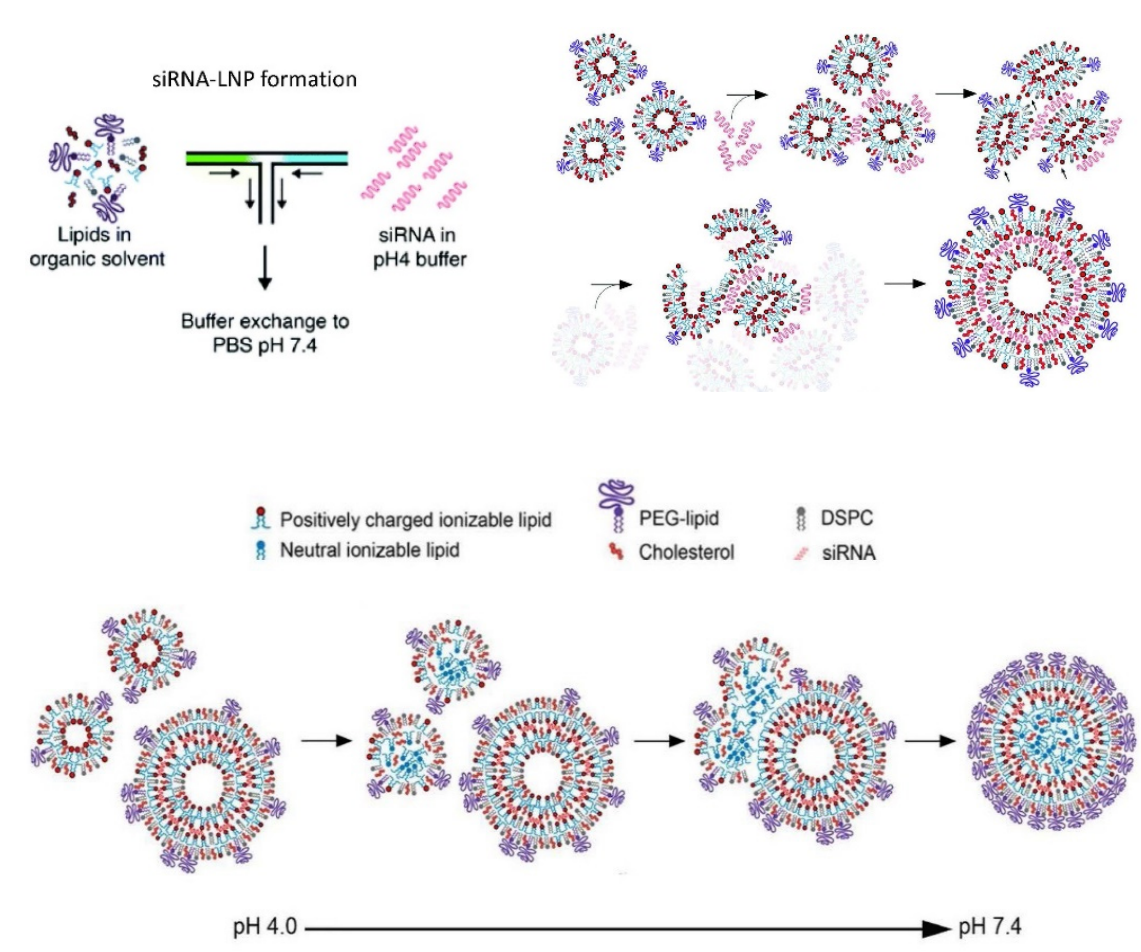
Figure 30. Schematic representation of the formation of siRNA-lipid nanoparticles (LNPs) for the delivery of siRNA to hepatocytes. Top, left : Drawing of the rapid mixing of an ethanolic solution containing the lipids in appropriate concentration and ratio (lipids in water-miscible organic solvent) with an aqueous solution of siRNA in buffer solution at pH = 4.0, using a T-mixer, followed by dialysis (buffer exchange to PBS at pH = 7.4), from Kulkarni et al. (2020) [437]. Top, right : Illustration of the events taking place at the first phase of the LNP formation, after mixing at pH = 4.0, as published by Kulkarni et al. (2019) [437]. Experiments demonstrate that positively charged lipid vesicles form at the beginning, before siRNA molecules interact. The positively charged vesicles get then coated by anionic siRNA molecules, which leads to vesicle aggregation and the formation of multilamellar structures, which then undergo further transformations as shown in drawings at the bottom. Bottom : Proposed mechanism for the formation of siRNA-containing LNPs in the second phase of the preparation process, as published by Kulkarni et al. (2018) [430]. Upon neutralization by dialysis with PBS ( pH = 7.4) of the cationic ionizable lipids present in the dispersion of multilamellar structures, which form in the first phase at pH = 4.0, the cationic ionizable lipids get deprotonated and generate a metastable oil-phase, which transforms via fusion processes to the final LNPs with surface localized PEG chains and internal siRNA molecules that are sandwiched between layers of lipids and a lipid core consisting of neutralized lipids [430,437]. Reproduced with permission from [437], Royal Society of Chemistry, 2020; and from [430], American Chemical Society,